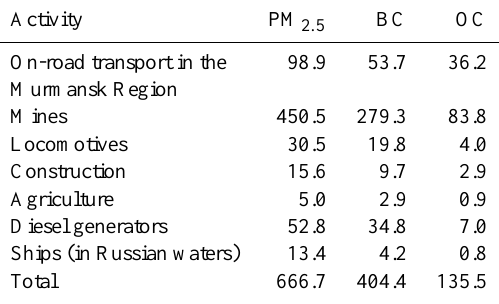
Table 7. BC emissions from on-road diesel vehicles in Russia in 2010 (t) (based on NIIAT methodology).